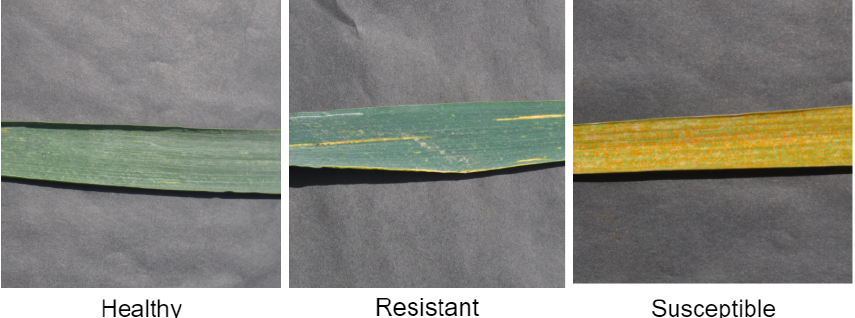
Figure 3. Wheat rust infection types.